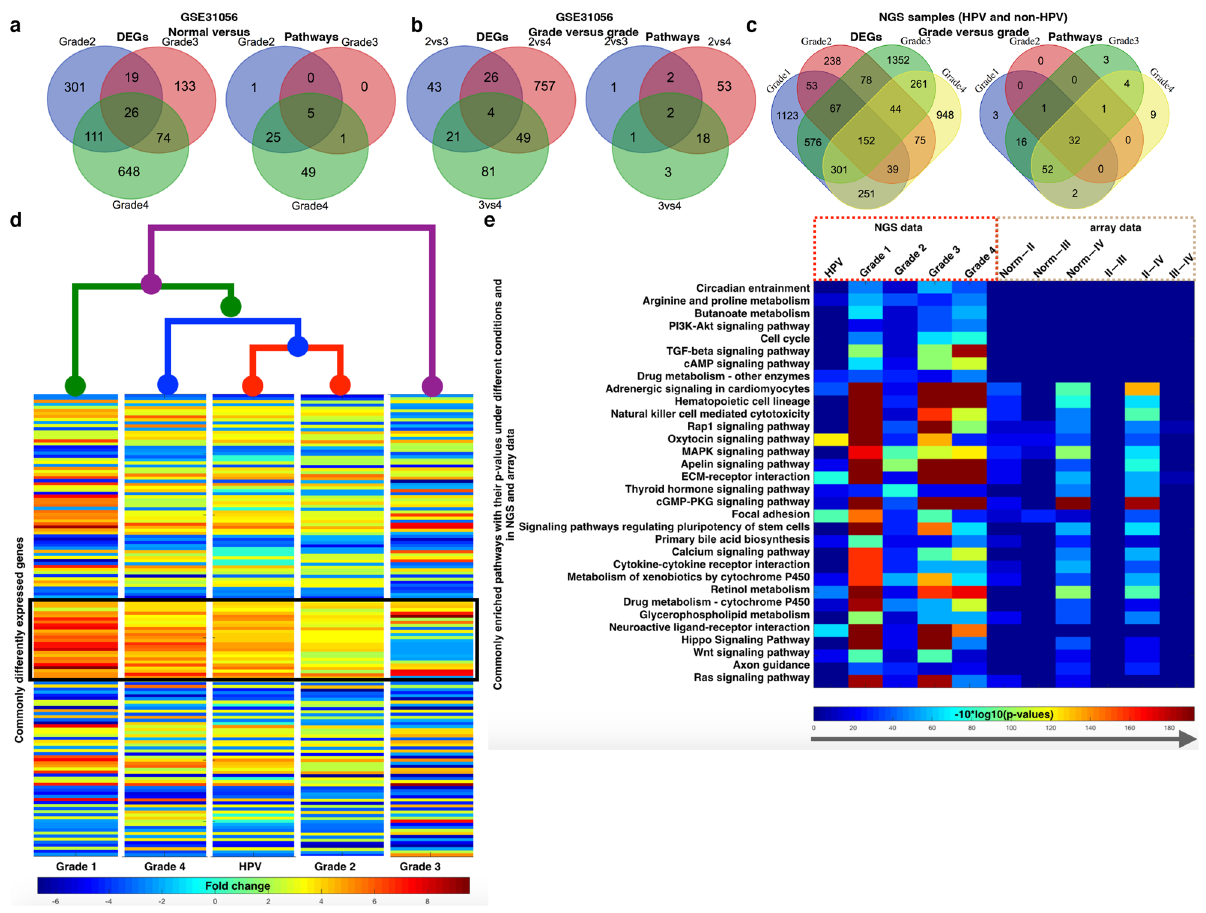
Figure 2. Differentially expressed genes and the enriched pathways for HPV infected oral cancer. Venn diagram for the different combinations of DEGs and the enriched pathways for ( a,b ) GSE31056 and ( c ) NGS dataset. ( d ) Heatmap and cluster for the 152 commonly DEGs in case of NGS data. ( e ) Commonly enriched 32 pathways for NGS dataset and the p-values for these pathways including the array